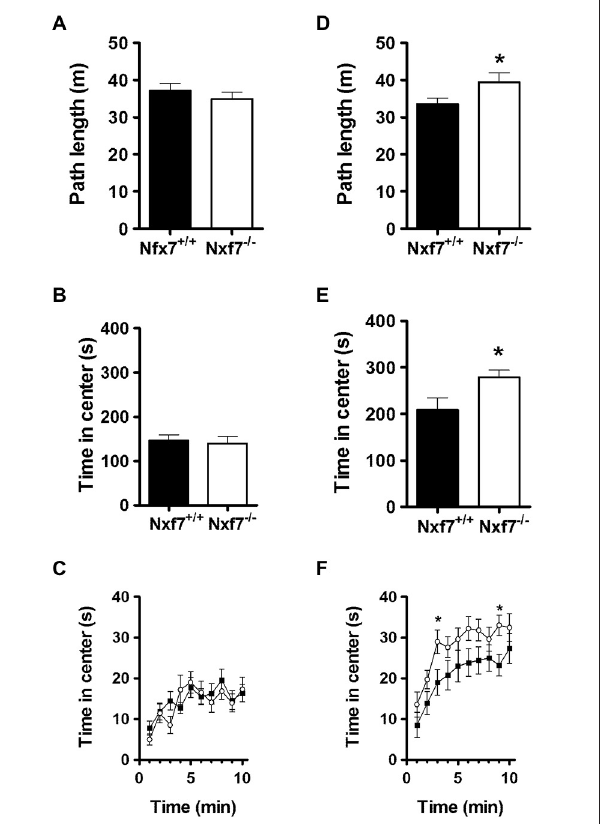
FIGURE 2 | Exploratory activity in the open field and during social exploration. In the open field, Nxf7 KO (open symbols) covered the same distance (A) , and spent the same amount of time in the center (B,C) , as their WT littermates (black symbols). When two female mice were placed in the center of the open field, male Nxf7 KO (open symbols) were more active (D) , and spent more time in the center (E) , and approached the two female mice sooner (F) than their WT littermates. Data are presented as means ± SEMs. * p < 0.05 Nxf7 KO vs. WT.